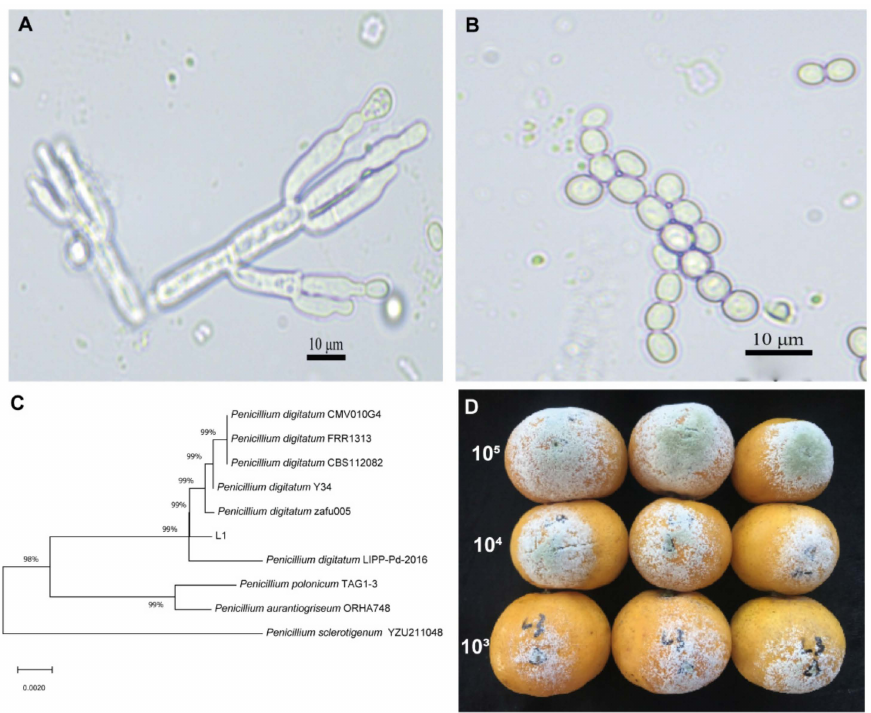
Figure 1. ( A , B ) Morphological characteristics of Penicillium digitatum strain L1 with conidiophores and spores. ( C ) Molecular phylogenetic tree of partial 18S rRNA gene sequence of P. digitatum L1.